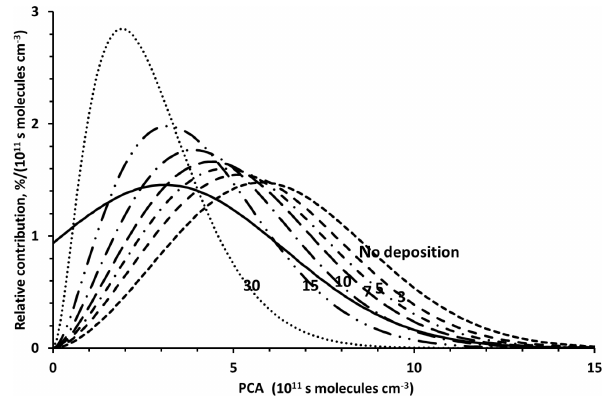
Figure 5. PCA distributions calculated for different depositional loss rates of 4-nitrophenol. The depositional loss rates are given as multiples of the chemical loss rate of 4-nitrophenol due to reaction with OH radicals. For comparison, the PCA distribution determined from the precursor carbon isotope ratio distribution (Kornilova et al., 2016) is also shown (solid line). The numbers on the graph in- dicate the OH-loss rates (similar to Fig. 6).